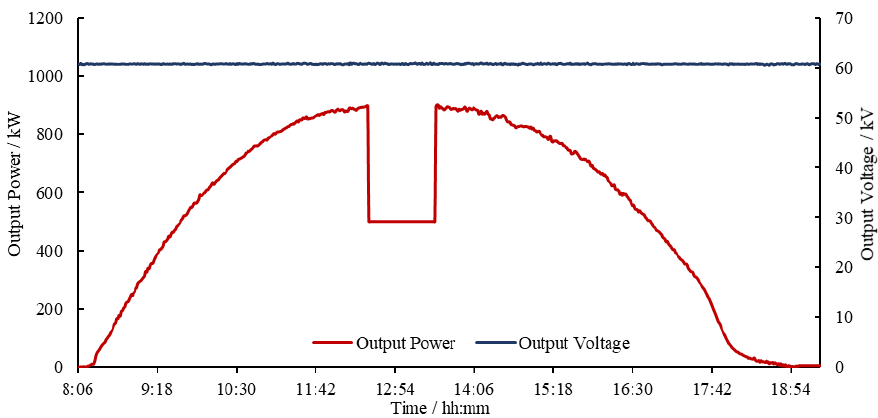
Figure 37. Output power and voltage of the DC/DC converter in power limiting mode.